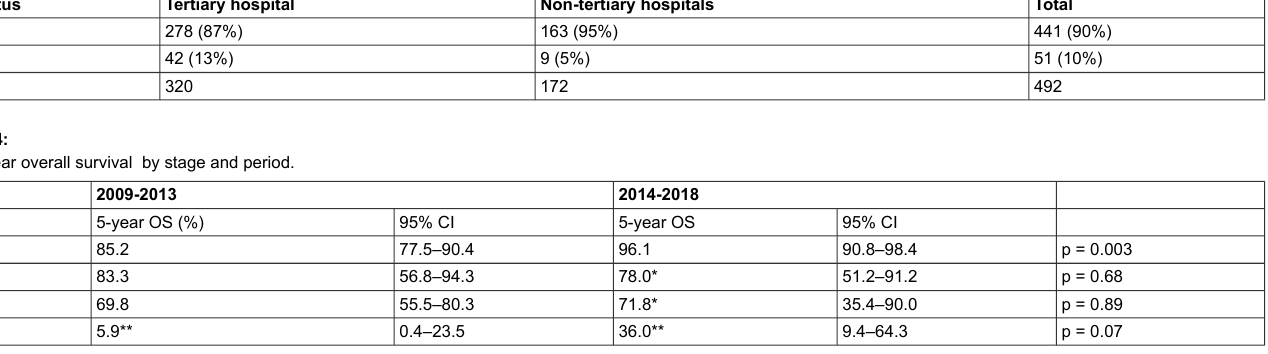
Table 3: Distribution of patients with (M-status 1) vs without (M-status 0) primary metastatic disease in tertiary and non-tertiary hospitals (p = 0.006). M-status